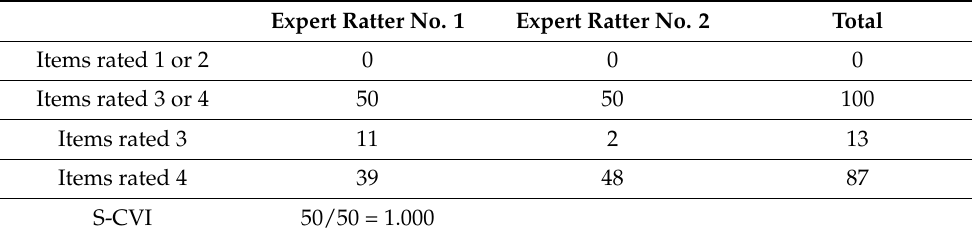
Table 3. Scale content validity of the DREEM tool.